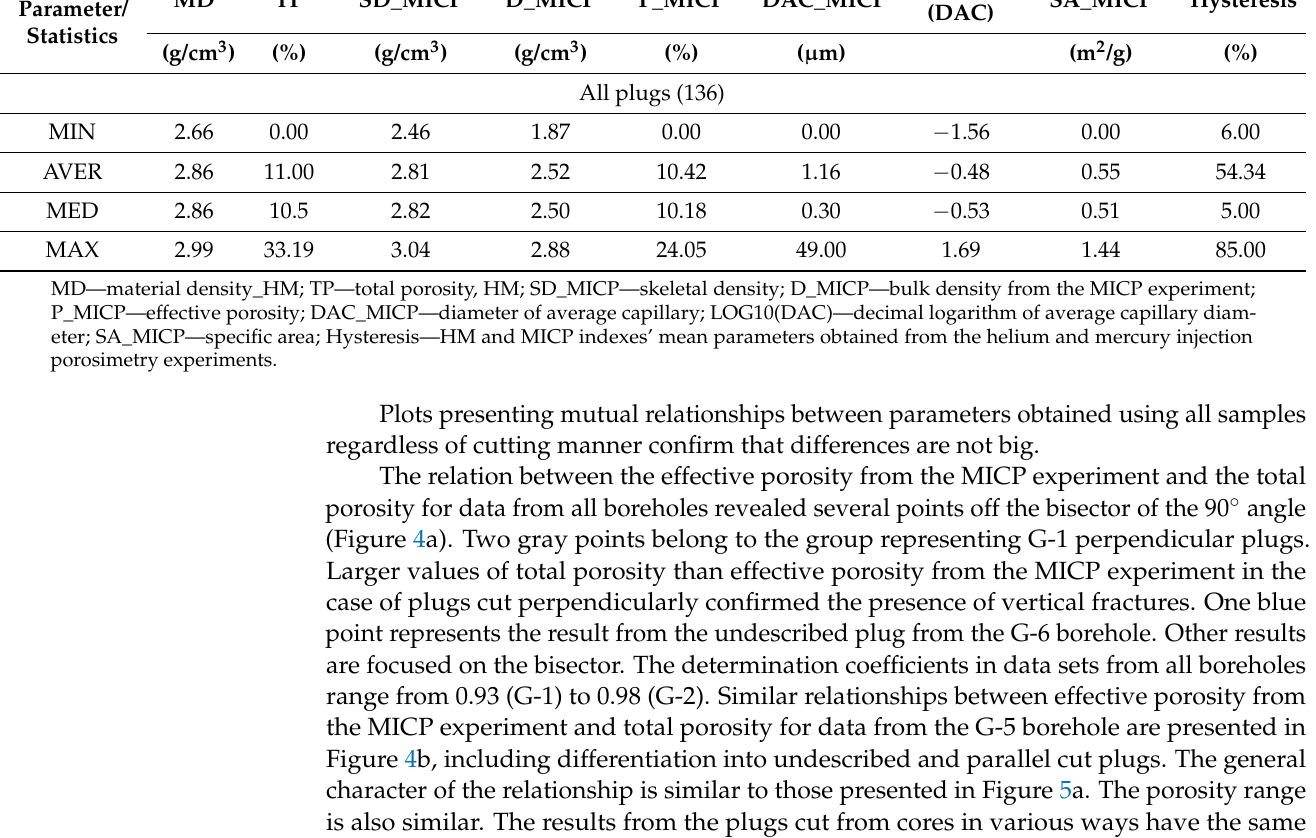
Table 1. Simple statistics (MIN—minimum, AVER—average, MED—median, MAX—maximum) of the petrophysical parameters obtained from the MICP experiment and helium porosity method on samples from all boreholes in the study. Parameter/